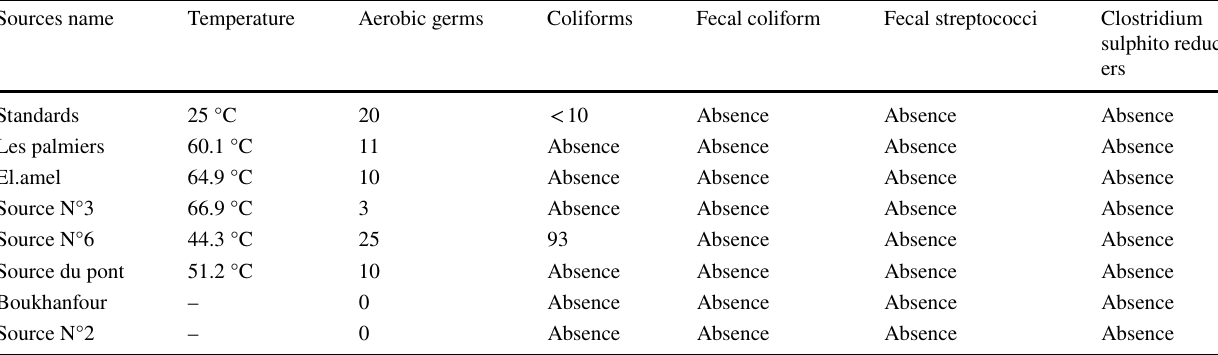
Table 4 The results of bacteriological analysis of spring sources samples Sources